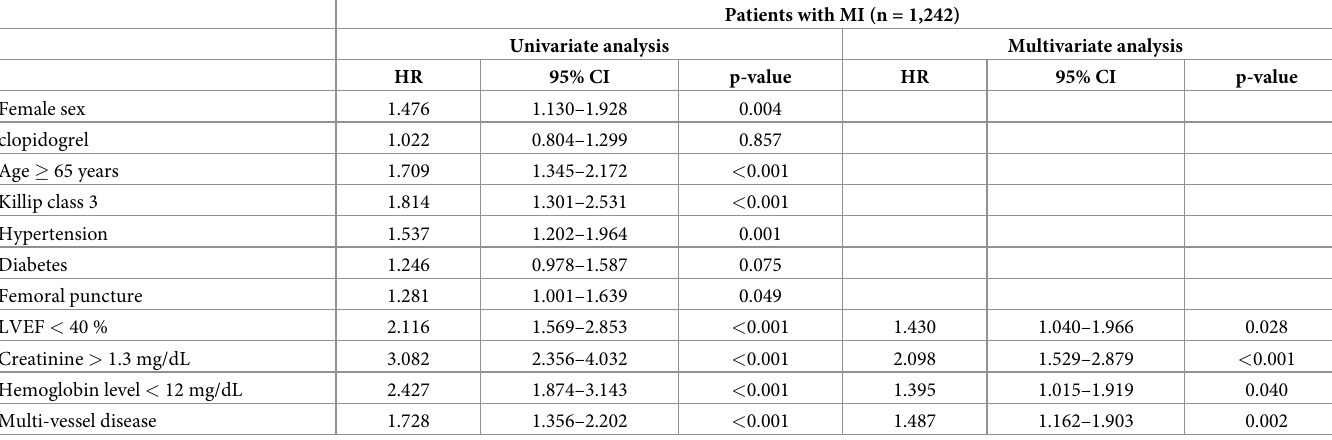
Table 5. Cox regression analysis for independent predictors of 3-year NACE in patients with acute myocardial